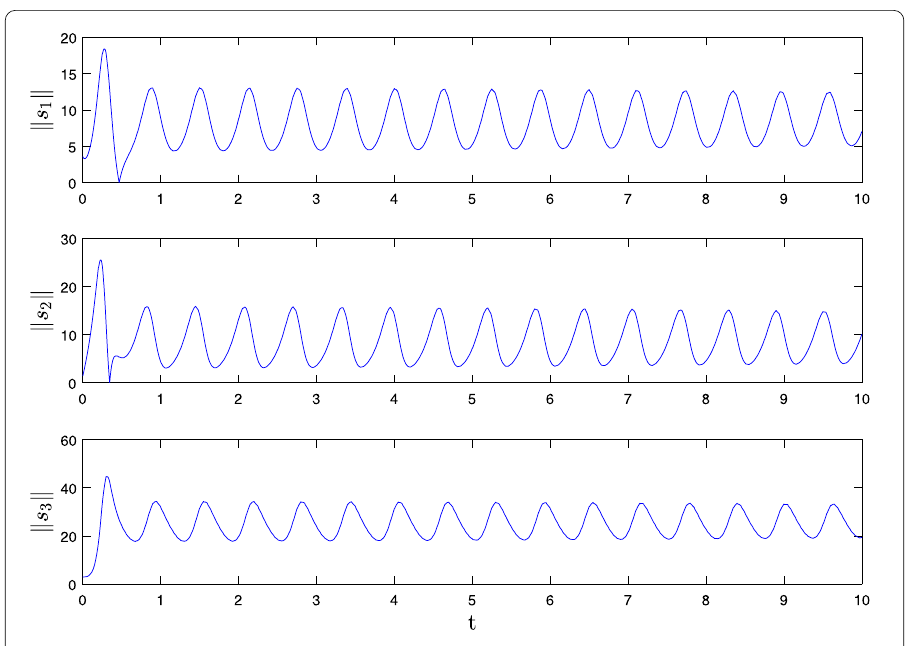
Figure 1 The orbits of (cid:9) s k ( t ) (cid:9) for fractional-order complex-variable Lorenz system with s (0) = (3 + 2 j ;1 + 1 j ;3) T